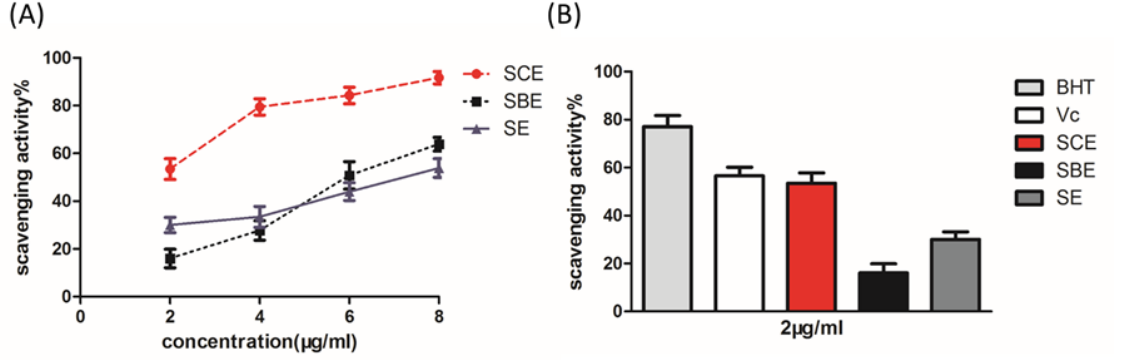
Figure 2: ABTS •+ radical scavenging activities of (A) CEOs and (B) compared with Vc and BHT at the concentration of 2μg/mL. Each value is expressed as mean ±